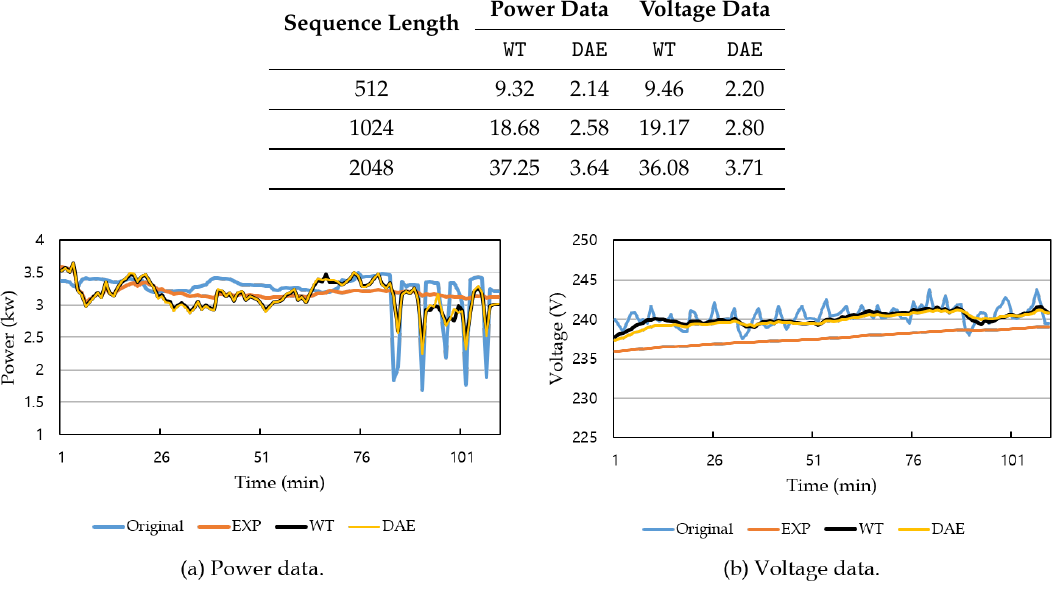
Figure 11. Example results of Kalman filtering.